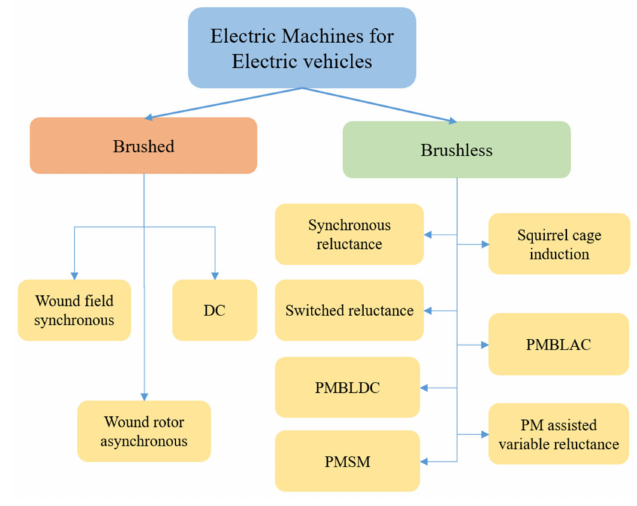
Figure 8. Motor types available for electric vehicles